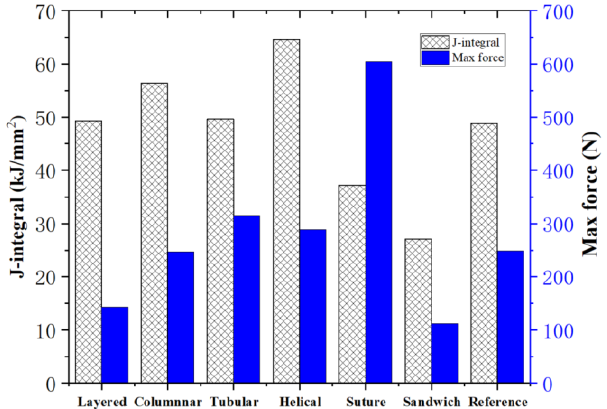
Figure 22. Maximum compression forces and toughness of the six bionic structures and the refer- ence model.